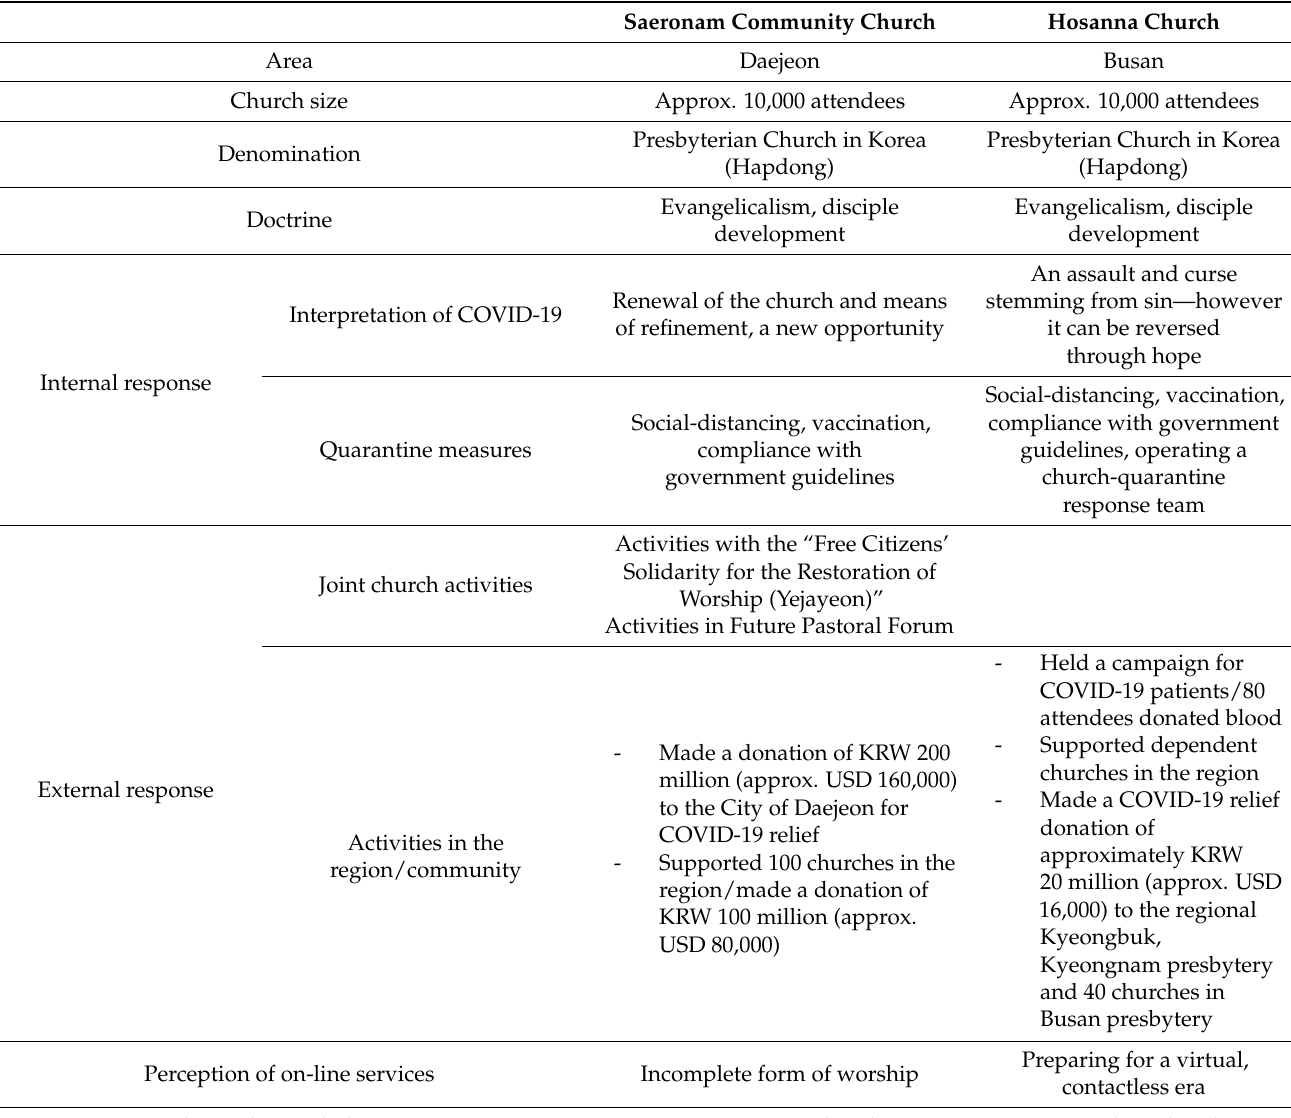
Table 1. The differences in the responses of the two churches to government